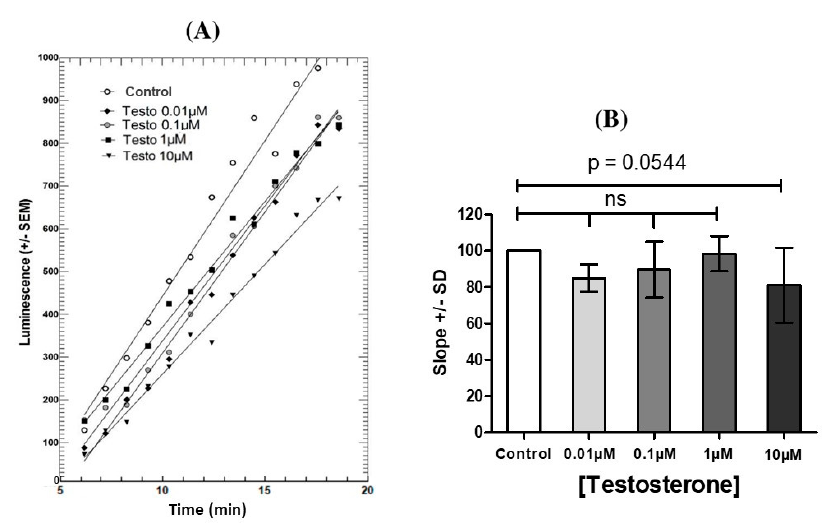
Figure 1. Effect of 1 h-preincubation with testosterone (Testo) alone on the cAMP accumulation in Mouse Leydig Tumor cells (mLTC)-1 cells under stimulation by 0.7 nM hLH. Left ( A ): Kinetics of oxyluciferin luminescence produced by cAMP-dependent luciferase in mLTC-1 cells stimulated by 0.7 nM rec hLH after 1h-preincubation with various concentrations of testosterone. Right ( B ): Dose- response effects from kinetics in panel (A). Each point represents the mean of luminescence in three